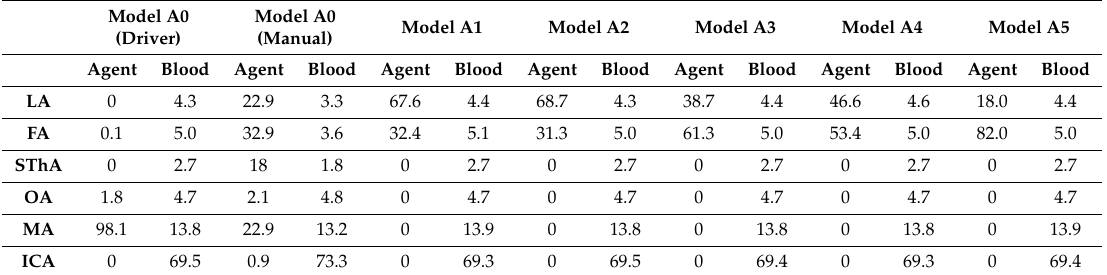
Table 1. Distribution rate (%) of anticancer agent and blood in models A0–A5.